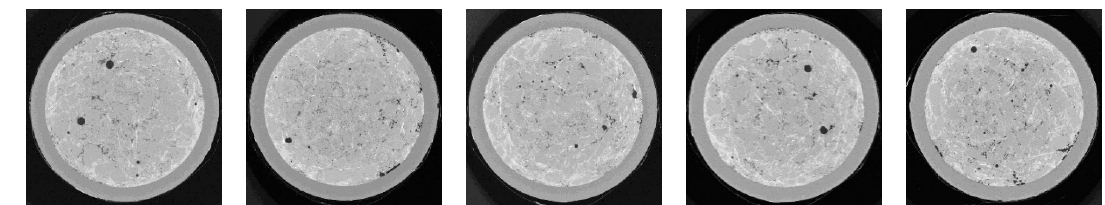
Figure 3. Slices belonging to steel fiber-reinforced concrete at different ages.